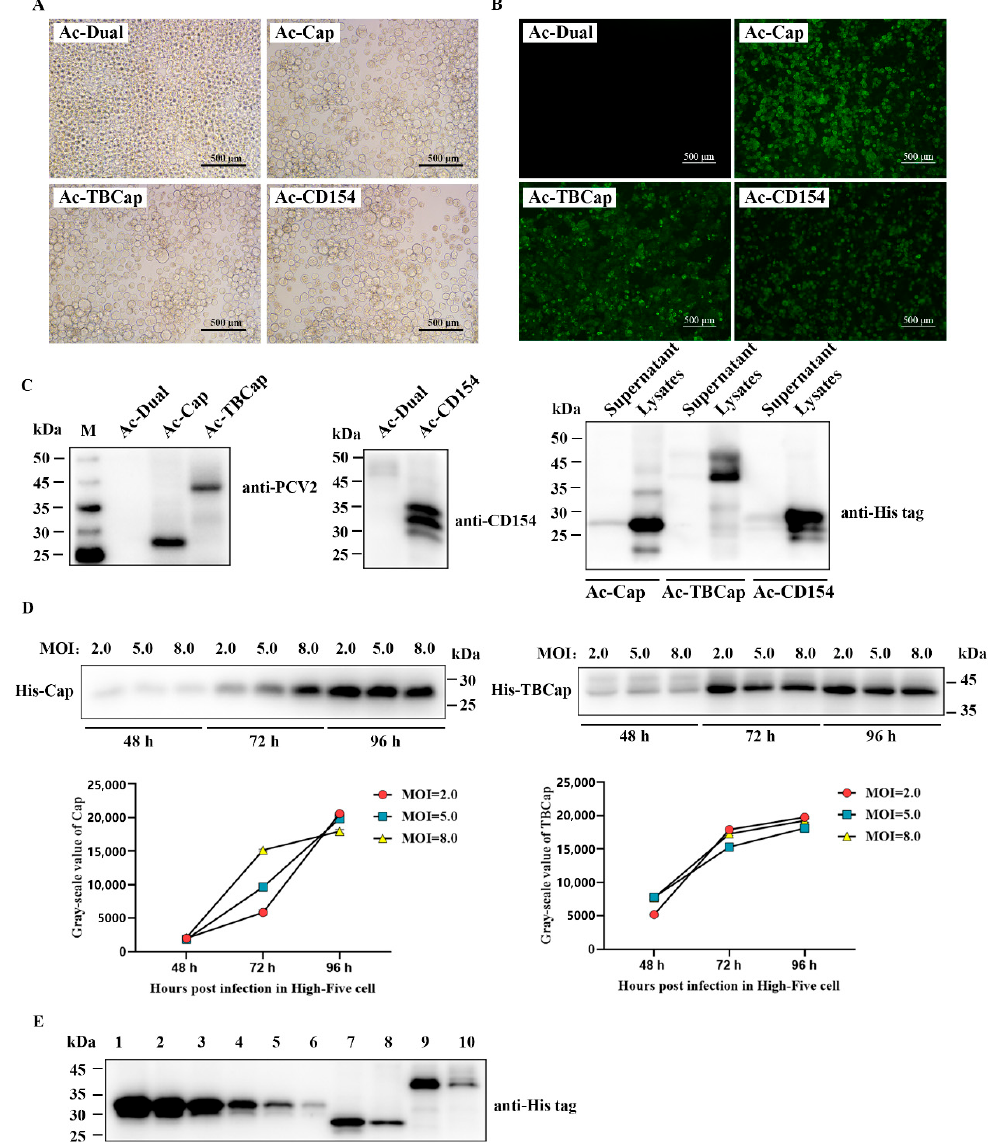
Figure 2. Identification of recombinant protein expression, optimization of conditions and semi- quantitative analysis. ( A ) Normal sf9 cells and sf9 cells showed CPE after transfection. ( B ) Observa- tion of recombinant protein expression by IFA. ( C ) Identification of recombinant protein expression by Western blot. ( D ) Optimization of expression conditions for recombinant proteins. ( E ) Semi- quantitative analysis of recombinant proteins. Lanes 1–6 are, in order, 1000 µg/mL, 750 µg/mL, 500 µg/mL, 250 µg/mL, 100 µg/mL, and 50 µg/mL concentrations of standard protein; lanes 7 and 9 are cell lysates infected with Ac-Cap and Ac-TBCap, respectively; lanes 8 and 10 are cell culture super- natants infected with Ac-Cap and Ac-TBCap, respectively.